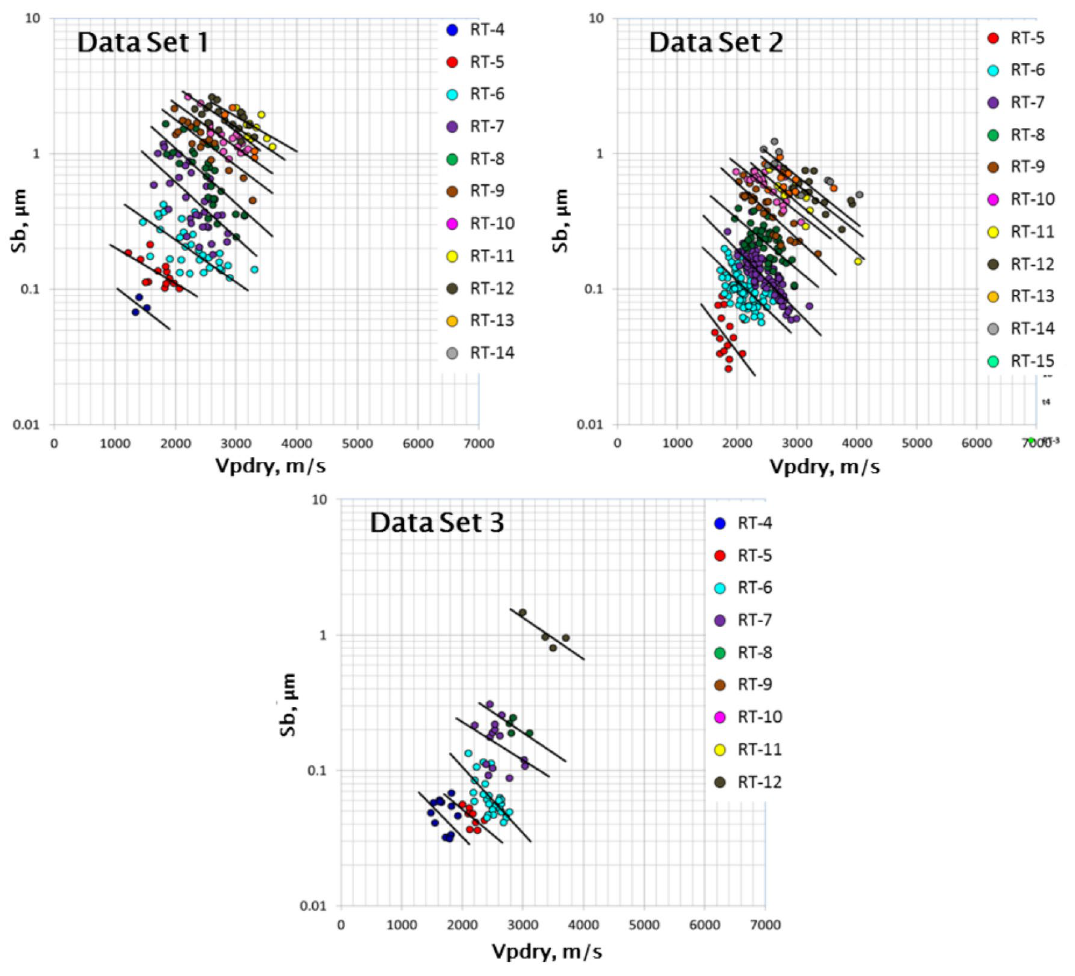
Fig. 6 Relationship between V